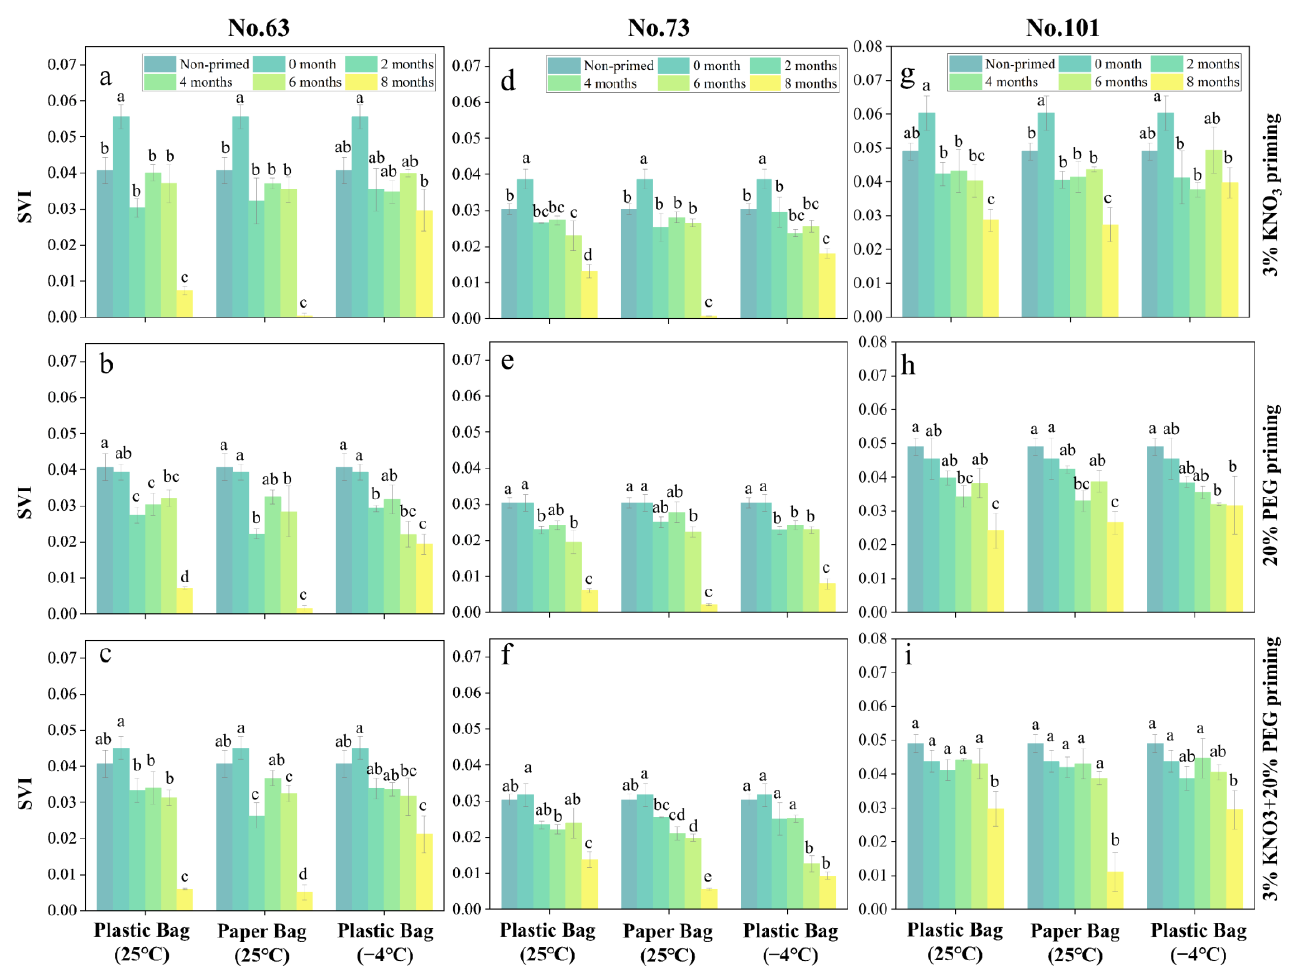
Figure 6. Simple vigor index of seedlings from primed pepper seeds under different storage condi- tions. SVI: simple vigor index = average fresh weight × germination percentage. ( a – c ) the simple vigor index for No.63 pepper seeds; ( d – f ) the simple vigor index for No.73 pepper seeds; ( g – i ) the simple vigor index for No.101 pepper seeds. ( a , d , g ) 3% KNO 3 priming; ( b , e , h ) 20% PEG priming; ( c , f , i ) 3% KNO 3 + 20% PEG priming. Different letters in the same cultivar for each treatment denote the difference between the storage duration of a storage condition at the 5% level.